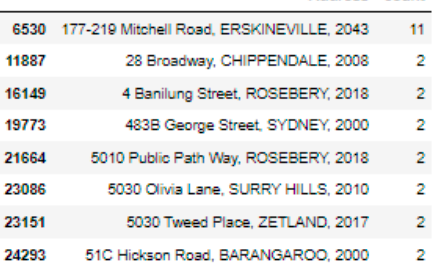
Figure 14. Addresses with multiple property boundaries.